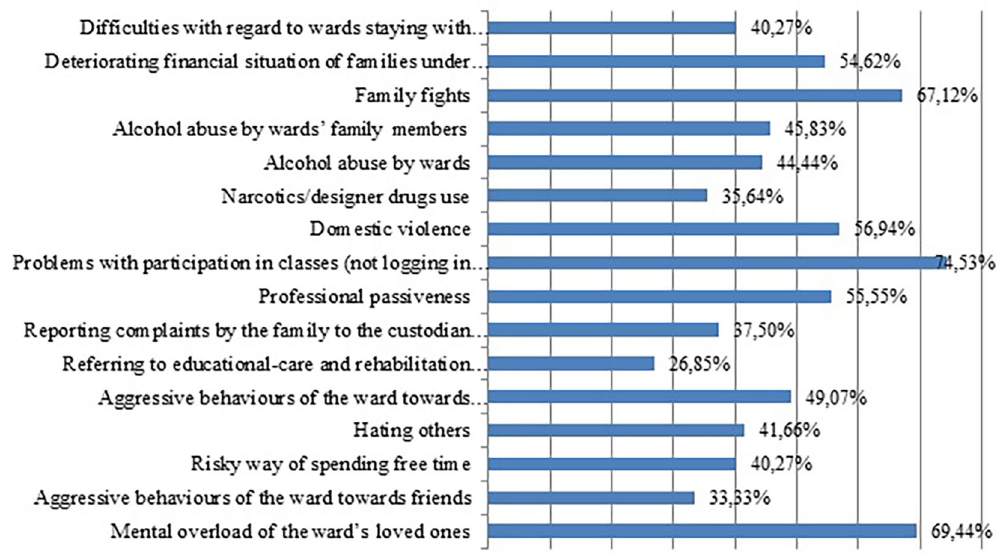
Figure 3. The increase in issues among families of wards under the court-appointed custodian ’ s supervision/ custody during the